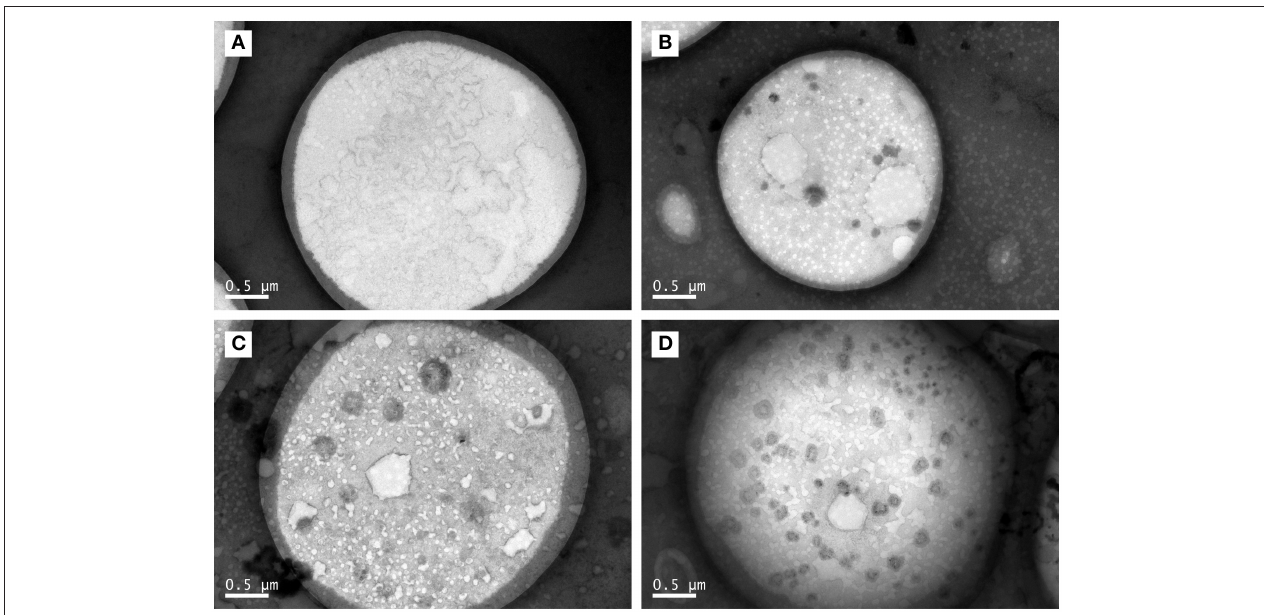
FIGURE 3 | TEM images of TCPs in tuna head soup at different boiling times. (A) 30min; (B) 60min; (C) 90min; and (D) 150min. Scale bars indicate 0.5 µ